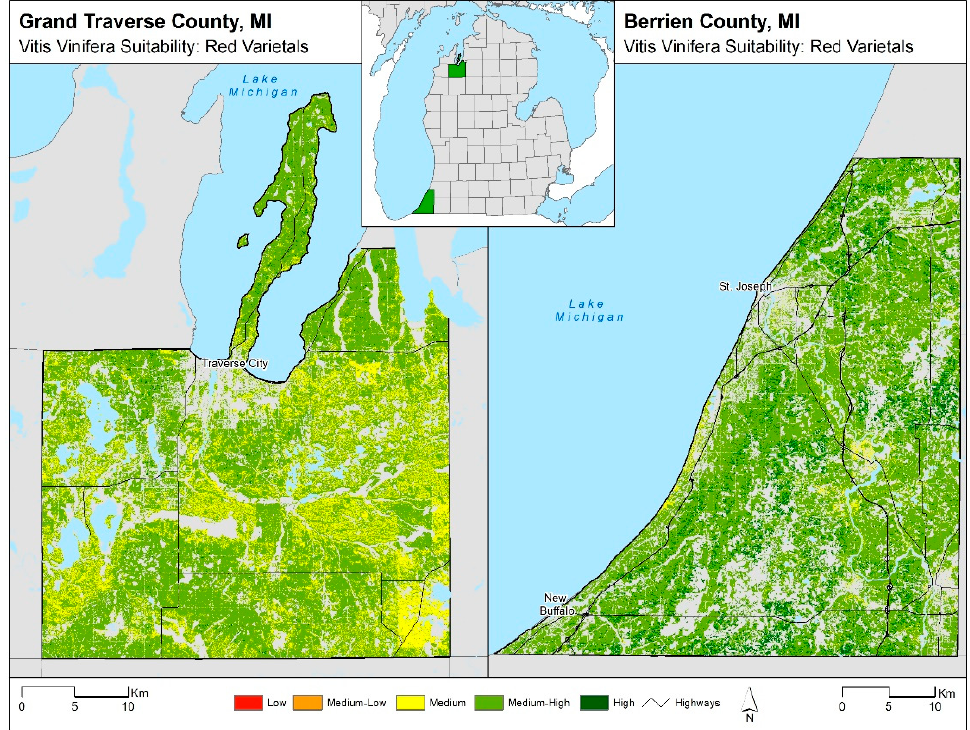
Figure 10. Suitability modeling results for red vinifera varietals across two of the seventeen studied counties. Example one ( left ) is Grand Traverse County in northwestern MI. Example two ( right ) is Berrien County in the southwest portion of the state.